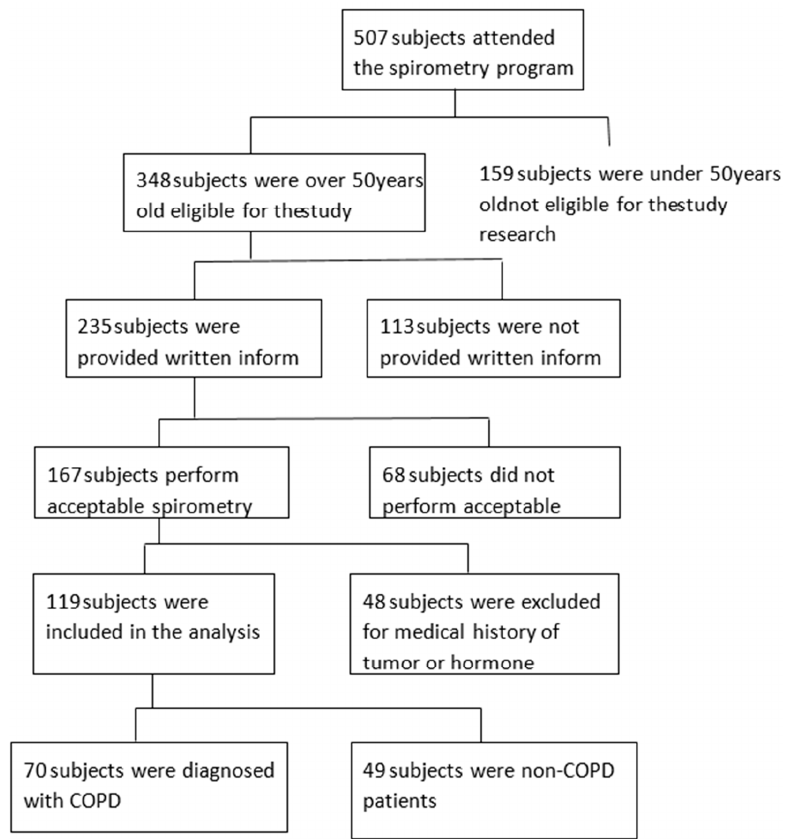
Figure 1. Flowchart of the study selection process. Notes: Exclusion criteria: No smoking history, age under 50 years old, a history of tumor disease or hormone replacement, or not capable of performing spirometry. Excluded subjects: 159 subjects aged <50 years, 48 subjects with hormone replacement and tumor history, and 68 subjects who did not achieve the spirometry